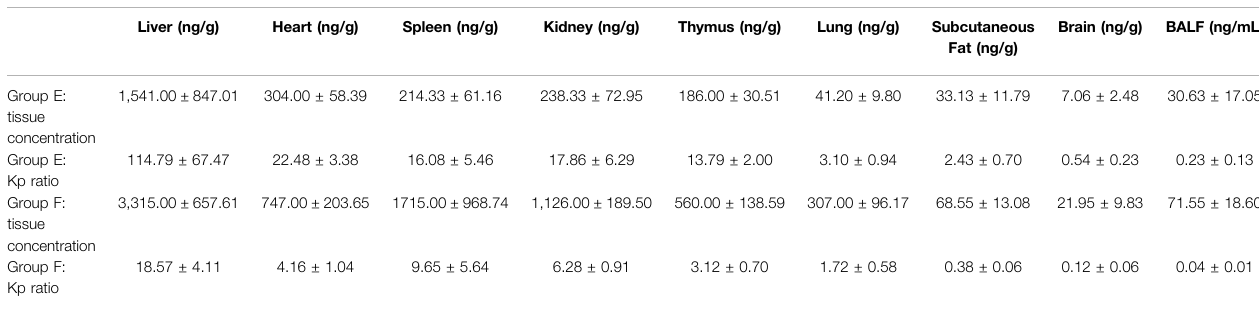
TABLE 2 | Tissues concentration (ng/g) and Kp_ tissue/blood ratio of DHCQ (mean ± SD). Liver (ng/g) Heart (ng/g) Spleen (ng/g) Kidney